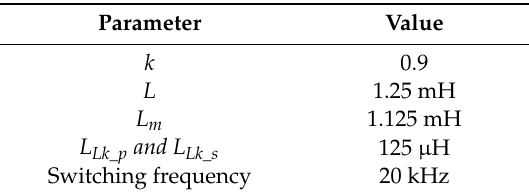
Table 2. Parameters for two-phase CI.